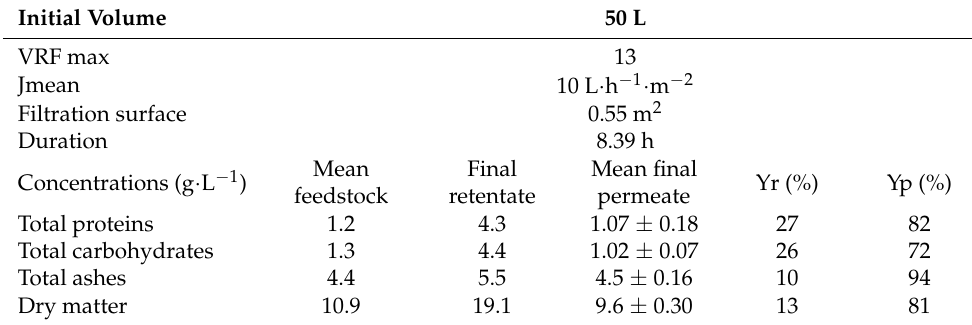
Table 2. Mass balance carried out following the ultrafiltration